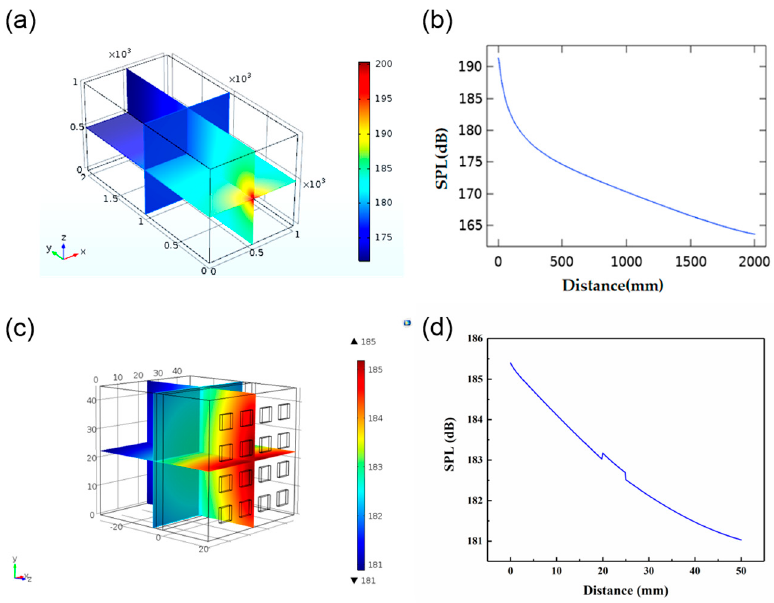
Figure 6. ( a ) Simulation of the distribution of sound field in water. ( b ) The relationship between sound pressure level (SPL) and distance. ( c ) Simulation model of the sound field through the skin tissue. ( d ) Changes in SPL through the skin tissue.